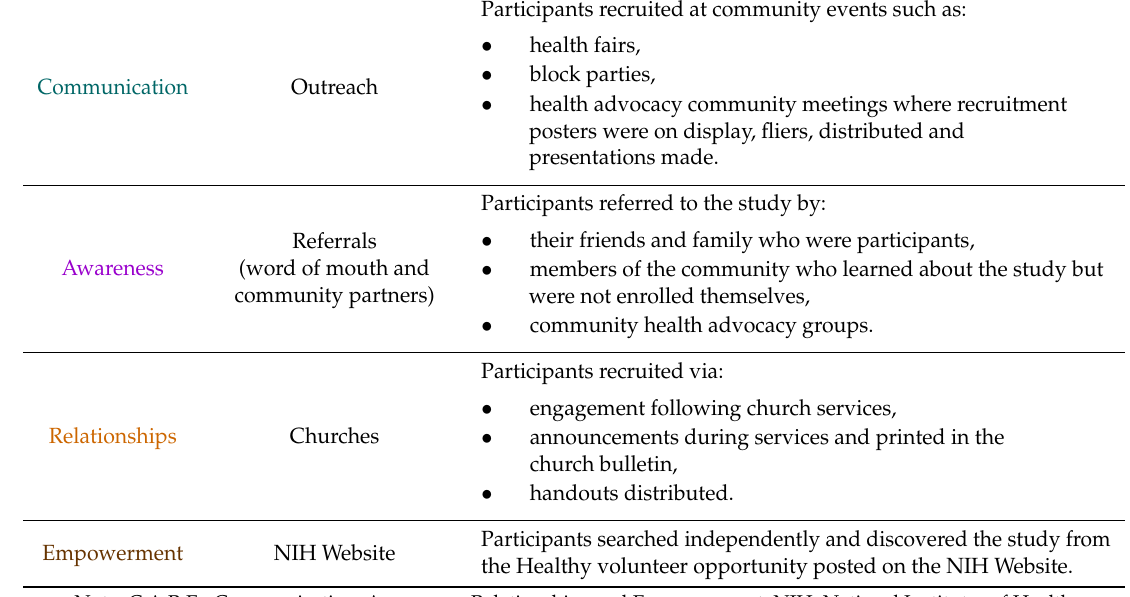
Table 1. C.A.R.E. Recruitment Strategies. C.A.R.E. recruitment strategies included capitalizing on church partnerships, encouraging referrals and outreach, and posting on the NIH website. Communication, Awareness, Relationship, Empowerment (C.A.R.E.) in Action: Recruitment Strategies